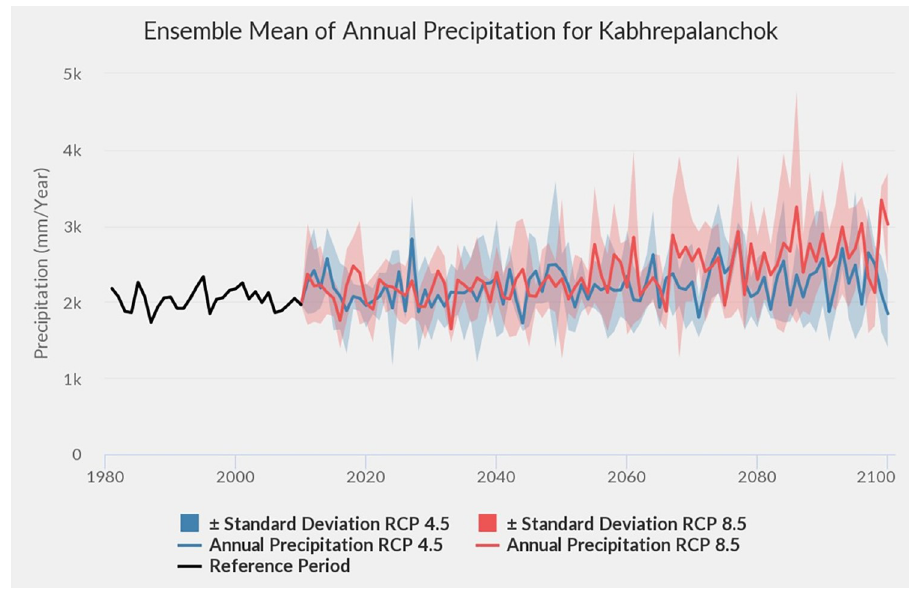
Fig 1. Ensemble mean of annual precipitation from Kavre district Nepal. (Source: MoFE, 2019).